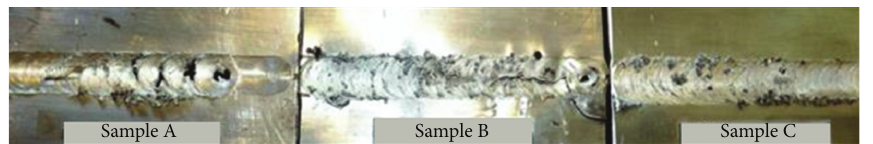
Figure 7: Photographs of samples A, B, and C.